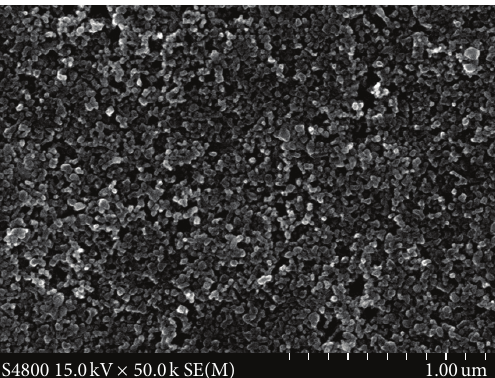
Figure 1: FE-SEM image of TiO 2 thin